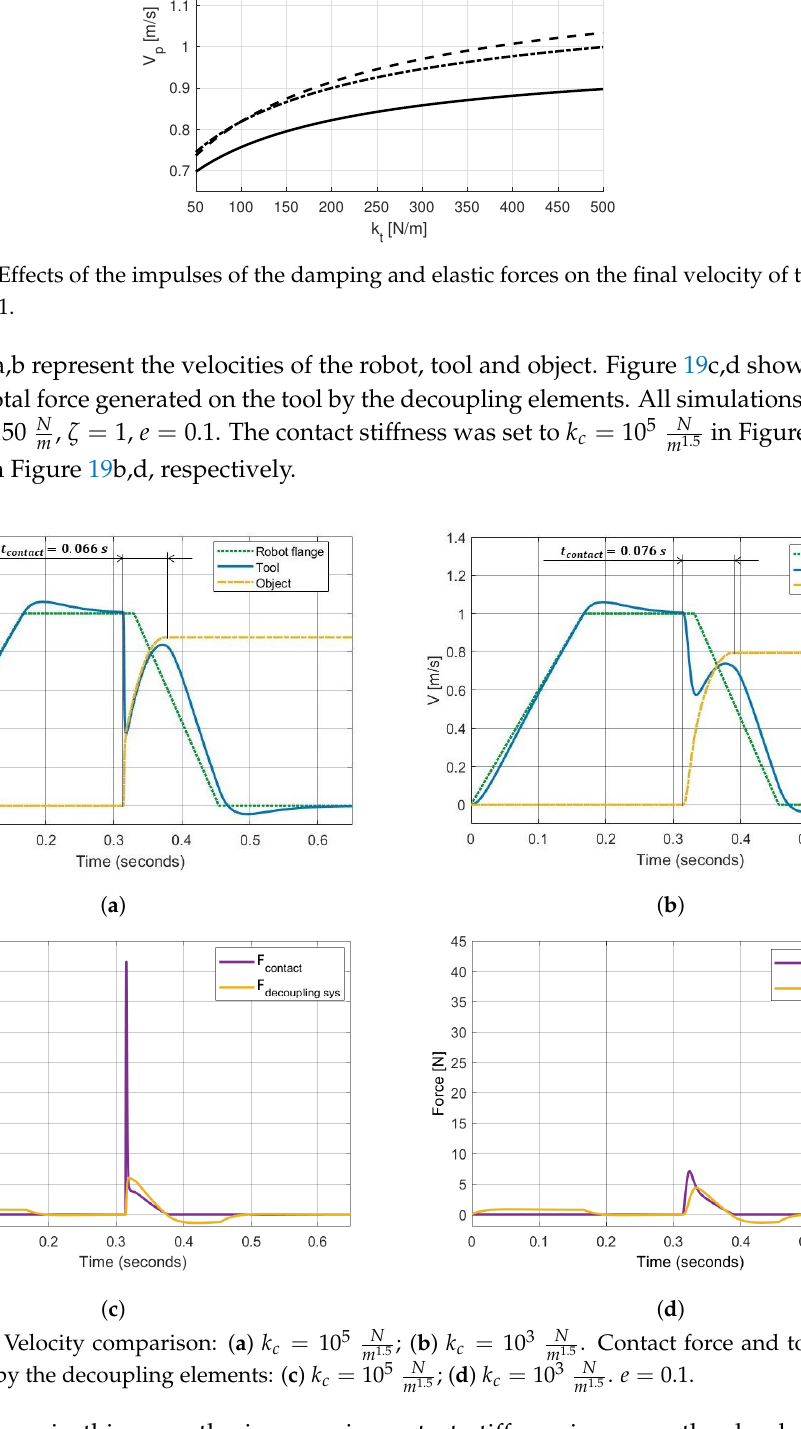
; ( b ) k c = 10 3 N . Contact force and total force m 1.5 m 1.5 ; ( d ) k c = 10 3 N . e = m 1.5 m 1.5